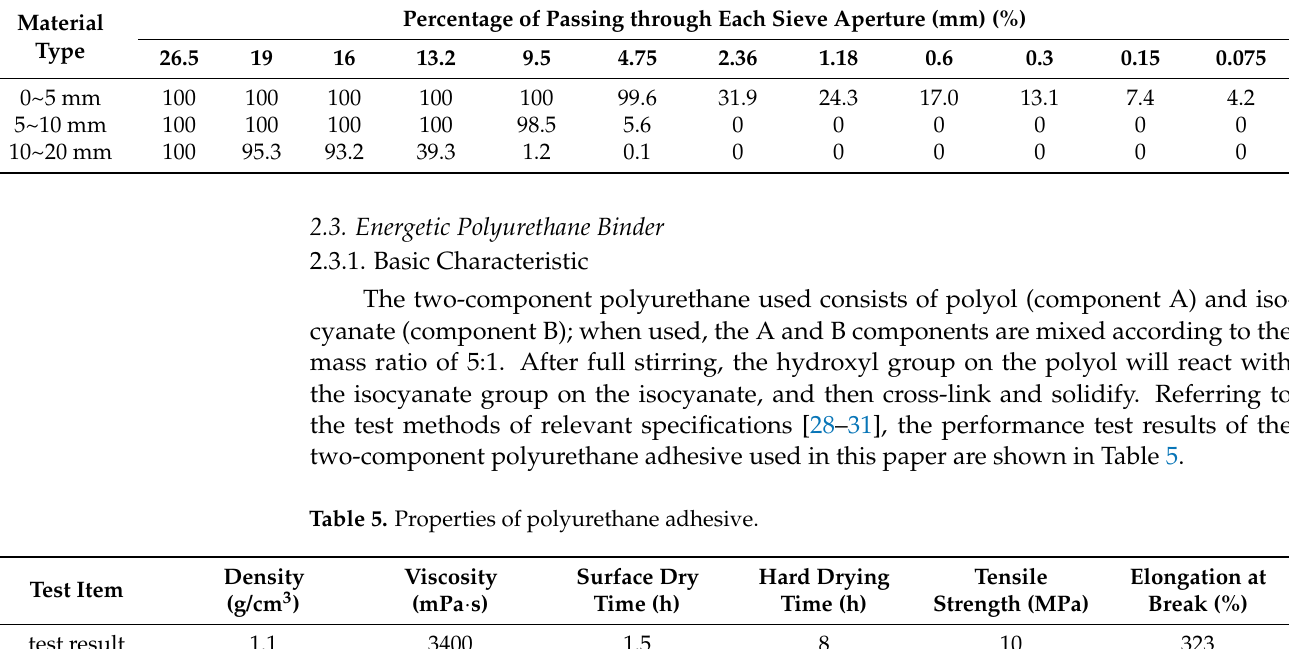
Table 4. Natural aggregate screening test results.